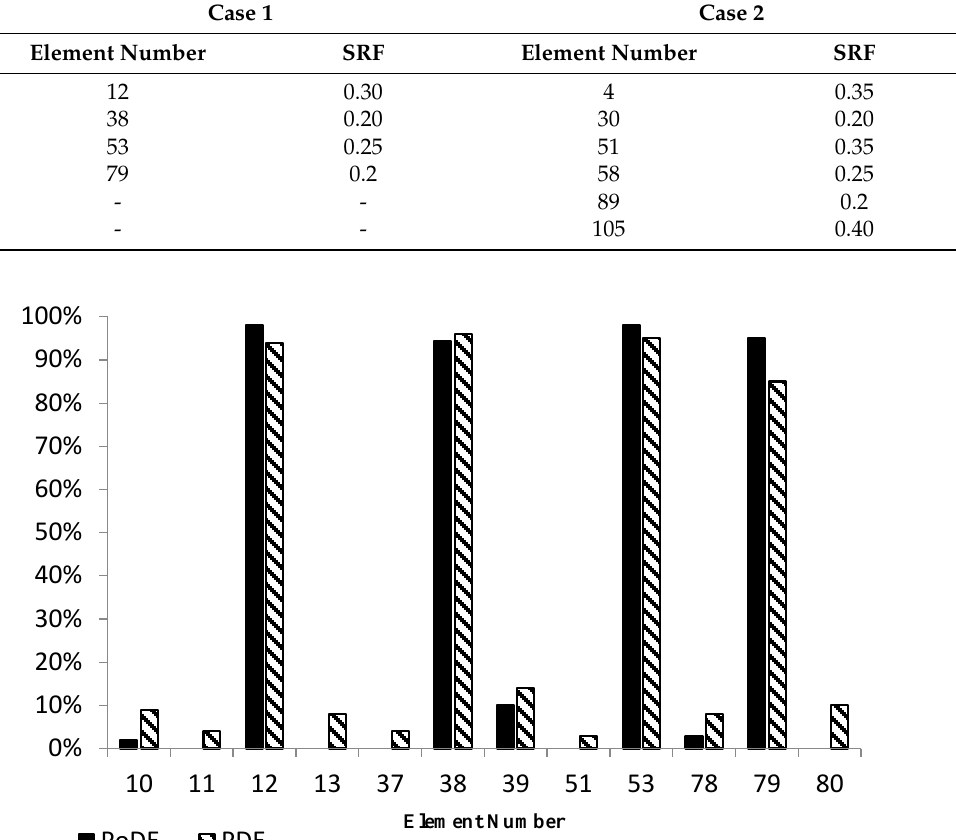
Figure 6. Probability of damage existence for damage case 1 of the dome truss.